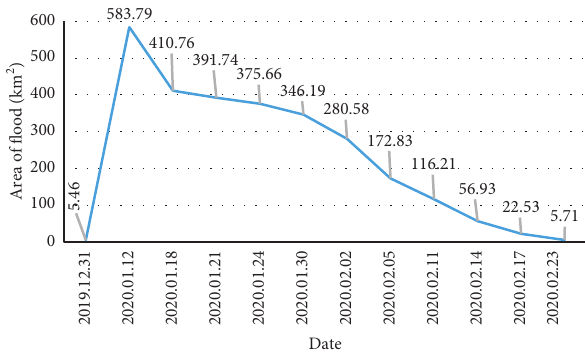
Figure 15: Diminishing cumulative area of flooding over twelve time periods.